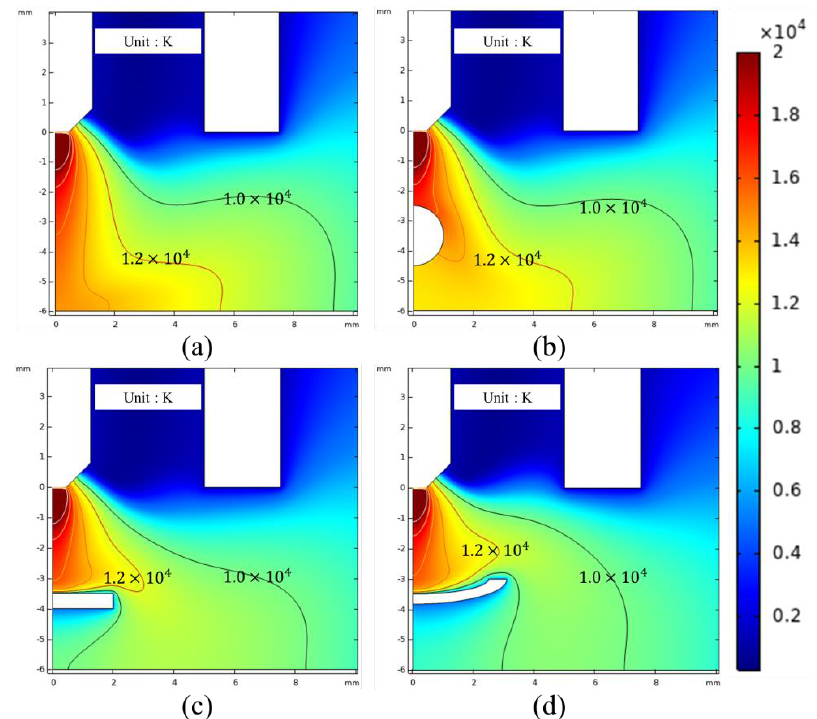
Figure 8. Temperature distribution of arc plasma according to obstruction structure shape: ( a ) None type; ( b ) Sphere shape; ( c ) Cylinder shape; ( d ) Concave shape. type; ( b ) Sphere shape; ( c ) Cylinder shape; ( d ) Concave